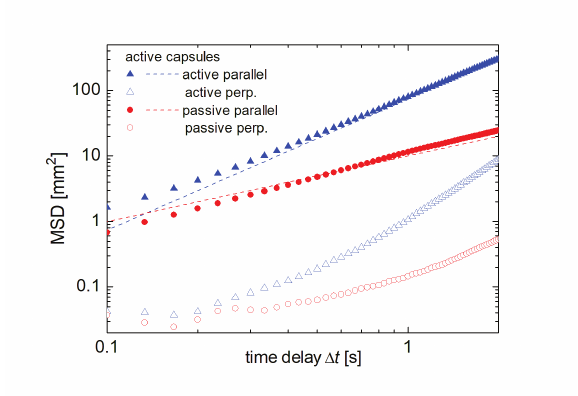
Figure 2. MSD for active and passive capsules on a hor- izontal plane at a = 1 . 6 g . The MSD along the long axis follows a (∆ t ) 2 dependence (blue dashed line) for active grains and ∝ ∆ t (red dashed line) for passive ones.